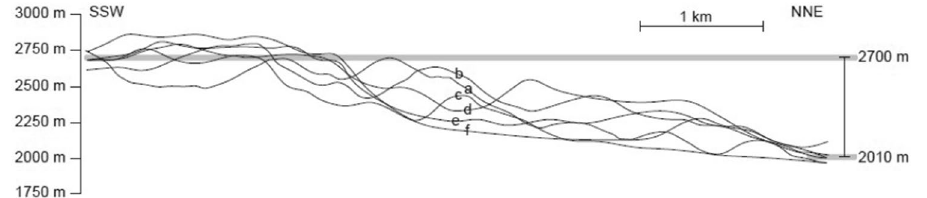
Figure 6. Six about 6 km long NNE–SSW topographic profiles have been constructed in the study area which shows a significant change (about 700 m) in the mean elevation between the Faryadoun Mountain and its northern area. See Fig. 3 for the locations.